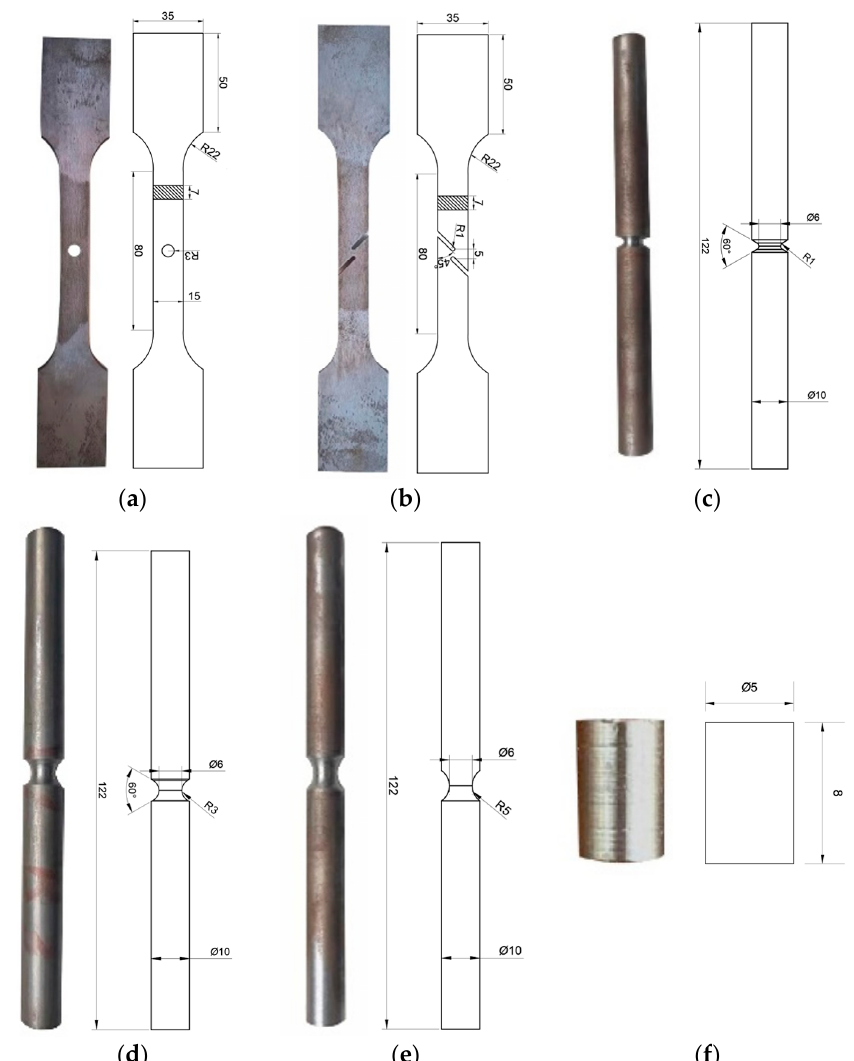
Figure 3. Weld special-shaped specimens (dimensions in mm): ( a ) CH6, ( b ) FS, ( c ) NRB1, ( d ) NRB3, ( e ) NRB5, and ( f ) compression.